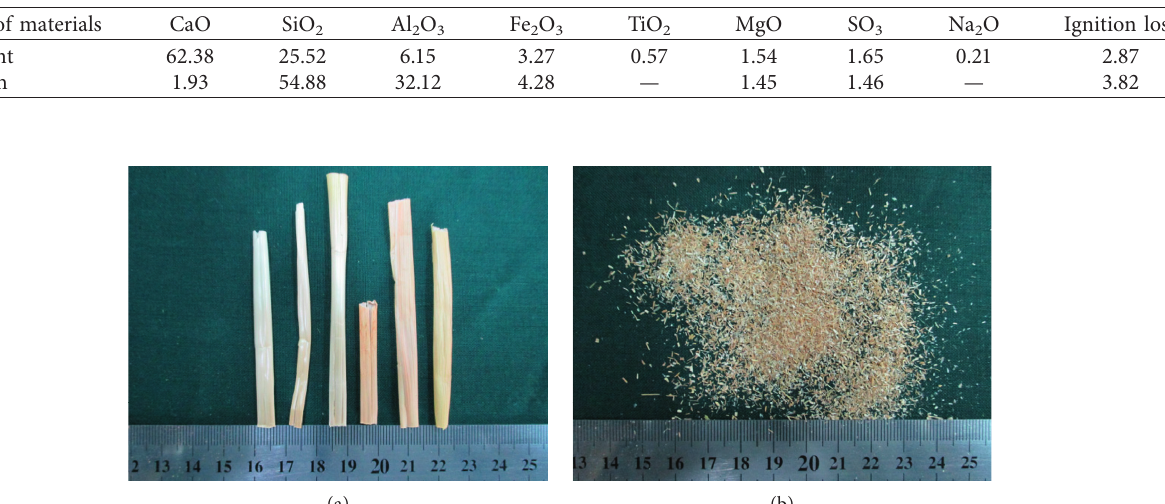
Table 1: Chemical composition of cement and mineral admixture (wt.%).